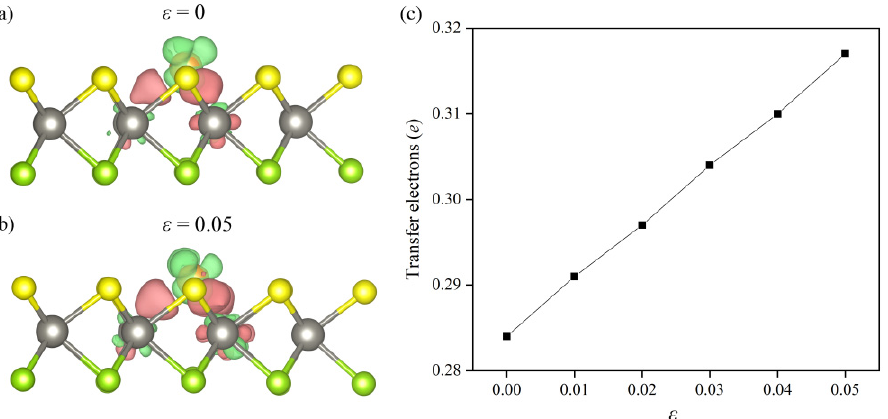
Figure 5. The 3D differential charge density plots of Au/WSSe ( a ) without and ( b ) with external tensile strain. The green and pink regions stand for electron depletion and accumulation, where the isosurfaces are set to 0.004 e/Å 3 . ( c ) The charge gained by the single Au atom in Au/WSSe under different tensile strain.